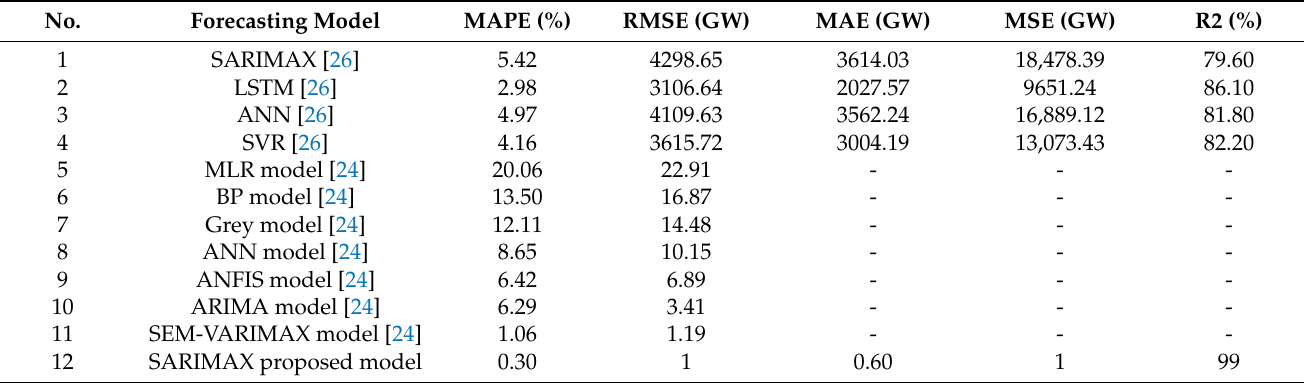
Table 2. Comparison of the performance of the proposed SARIMAX model and external